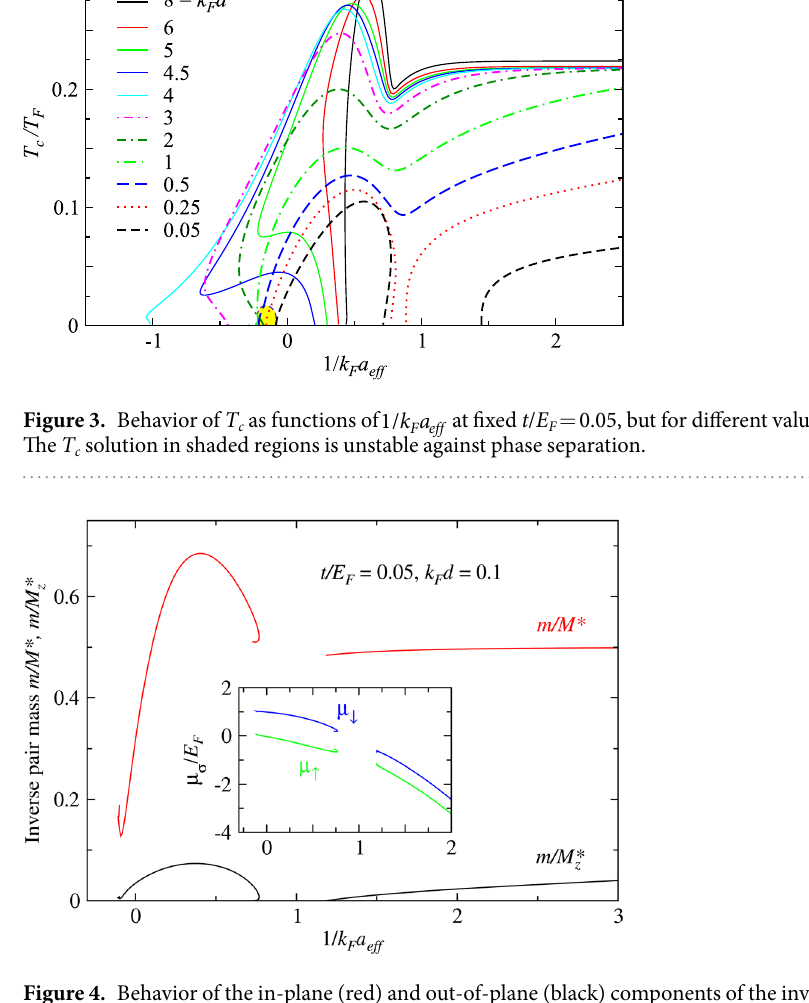
, for t / E F = 0.05 and F eff